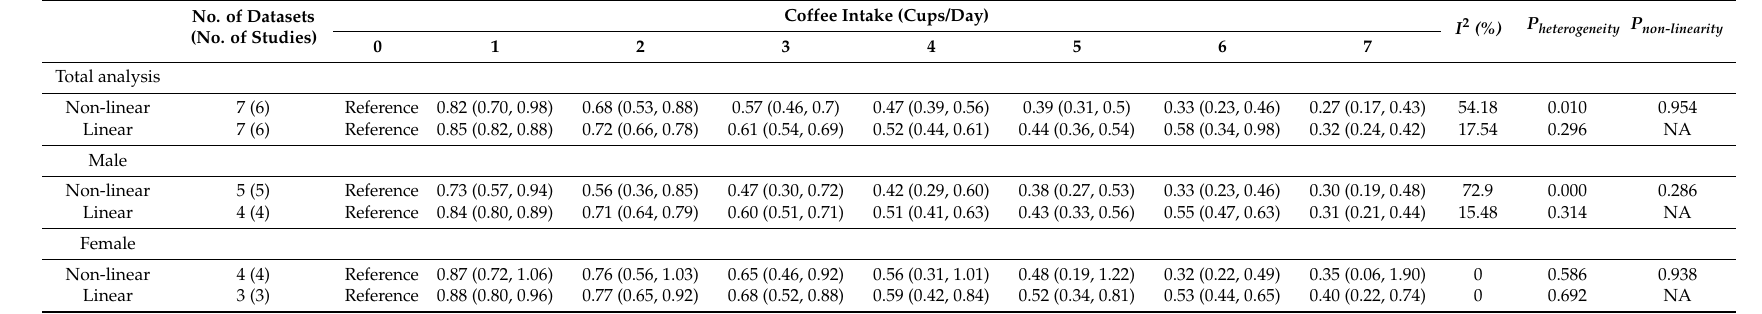
Table 4. Dose–response meta-analysis of prospective cohort studies on coffee consumption and